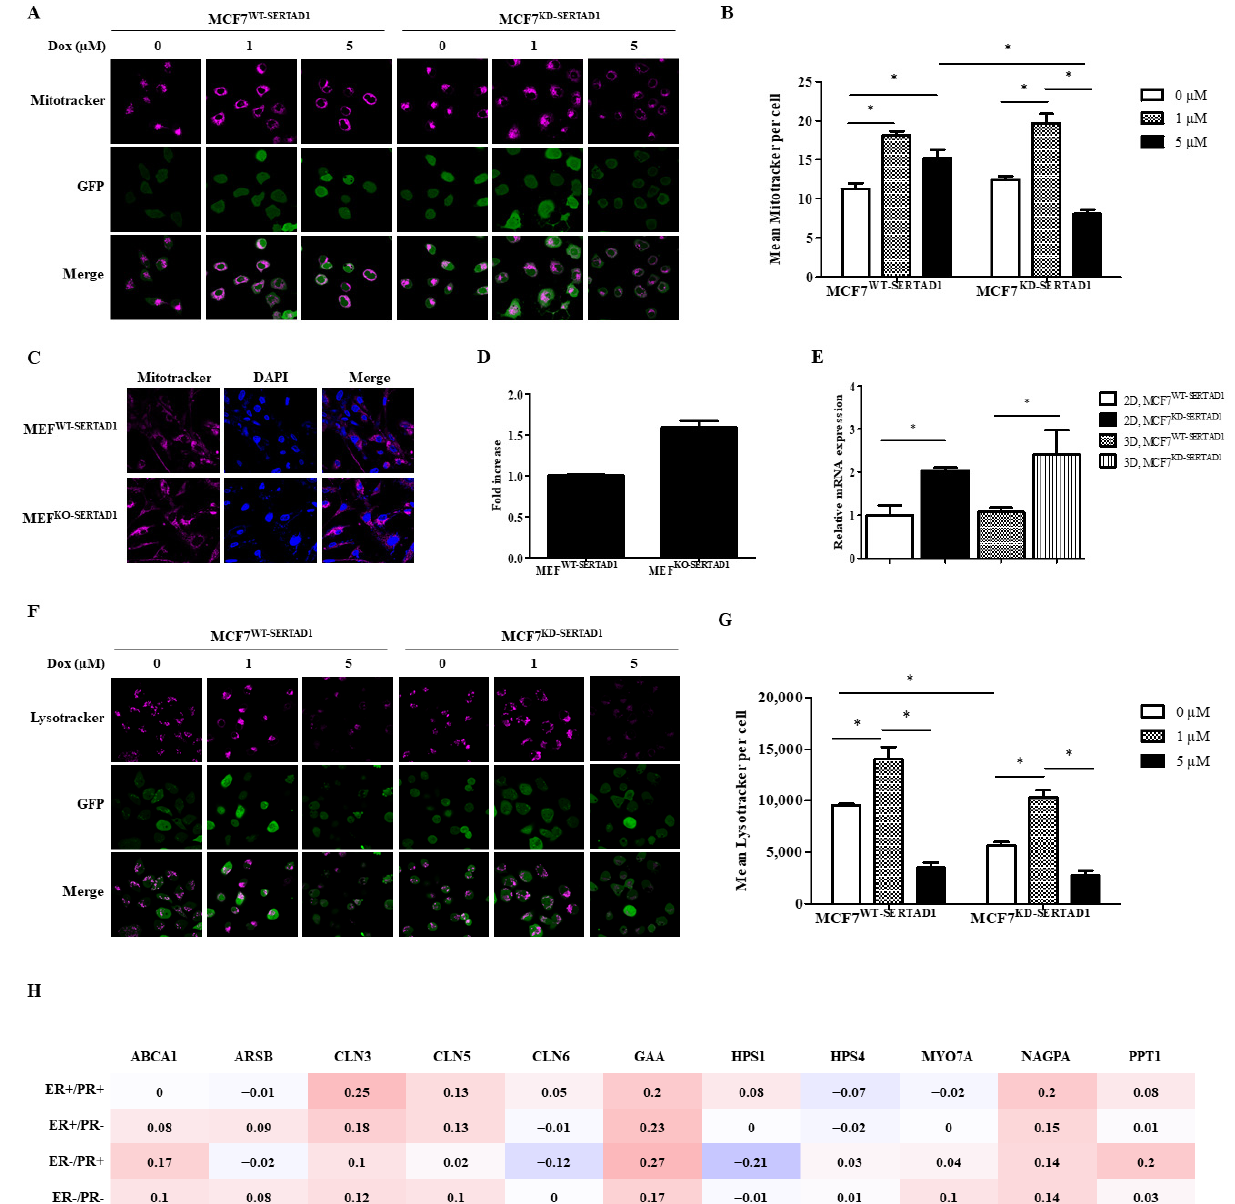
Figure 4. Inhibitory effect of SERTAD1 on apoptosis/anoikis partly via autophagy. ( A,B ) Mitochondrial contents of MCF7 WT-SERTAD1 and MCF7 KD-SERTAD1 cells in the presence of different concentrations of Dox. ( C,D ) Mitochondrial content of MEFs from SERTAD1 +/+ and SERTAD1 − / − mice using Mitotracker. Mean Mitotracker per cell was analyzed using ImageJ program. ( E ) Levels of mtDNA in MCF7 WT-SERTAD1 and MCF7 KD-SERTAD1 cells. Images and data are representative of at least three independent experiments. * p < 0.05. ( F,G ) Lysosomal contents of MCF7 WT- SERTAD1 and MCF7 KD-SERTAD1 cells in the presence of different indicated concentrations of Dox in adherent cultures. Mean LysoTracker per cell was analyzed using ImageJ program. ( H ) Heat map of DNA microarray data in breast cancer patients by bc-GenExMiner v4.5 program showing the correlation between SERTAD1 and LYSOSOME_ORGANIZATION_AND_BIOGENESIS gene set.